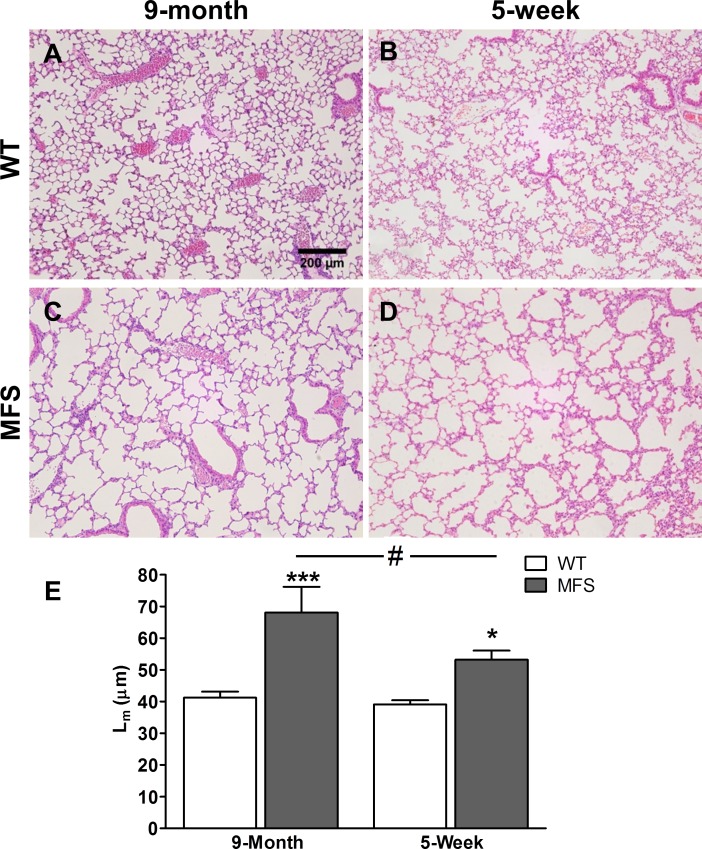
Histological analysis of mouse lungs.Representative H&E stained images of lung sections from (A) 9-month and (B) 5-week old wild-type (WT), and (C) 9-month and (D) 5-week old Marfan (MFS) mice. Images acquired at 100x magnification and scale bar represents 200μm. (E) Mean linear intercept (Lm) of alveolar septa. Data are mean ± SE. * p < 0.05; *** p <0.001 compared with their respective WT and # p < 0.05 between different ages in Marfan mice.